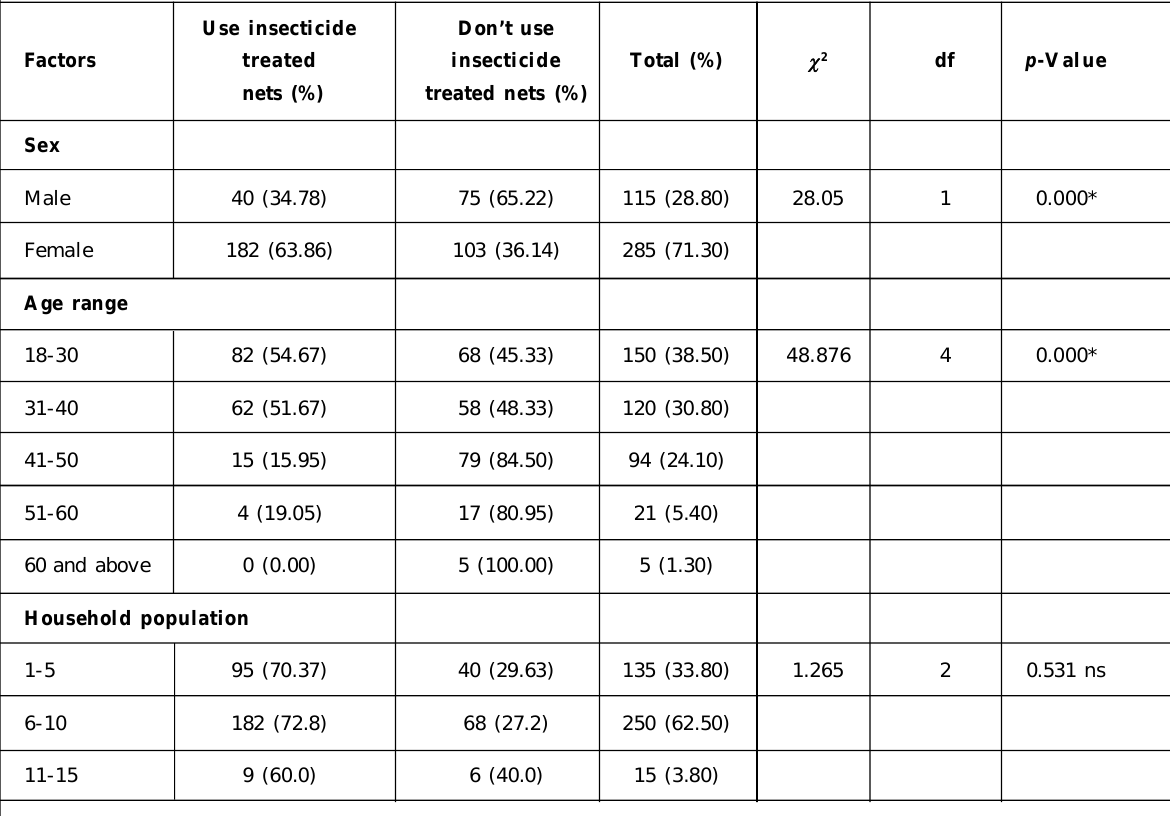
Table 4: Relationship between sociodemographic characteristics and insecticide treated net